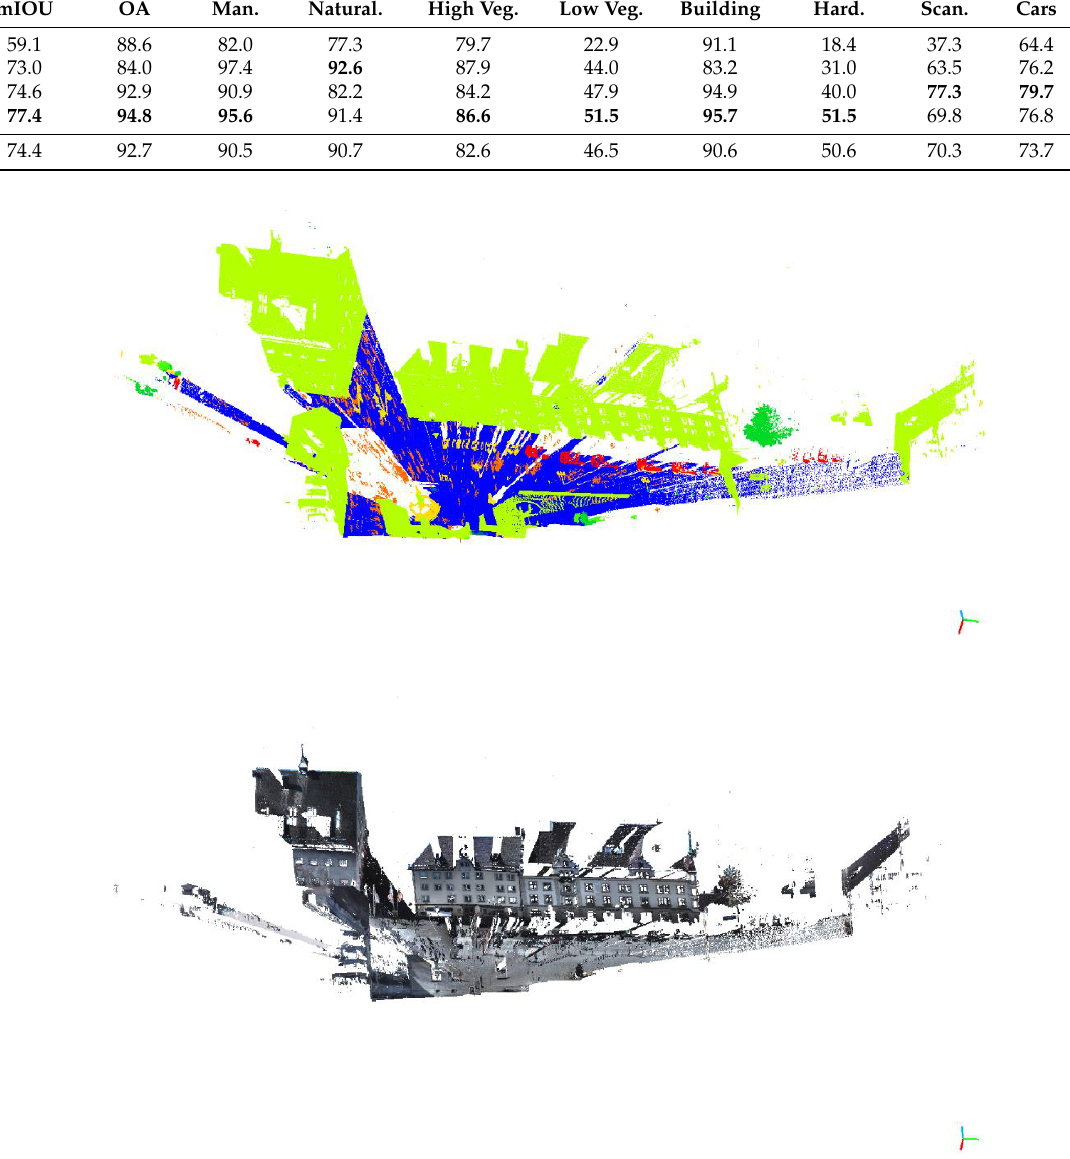
Figure 12. The semantic segmentation results for the validation data: The top panel shows the original data. The bottom panel is the predicted result. Table 4. Semantic segmentation results for the validation data.